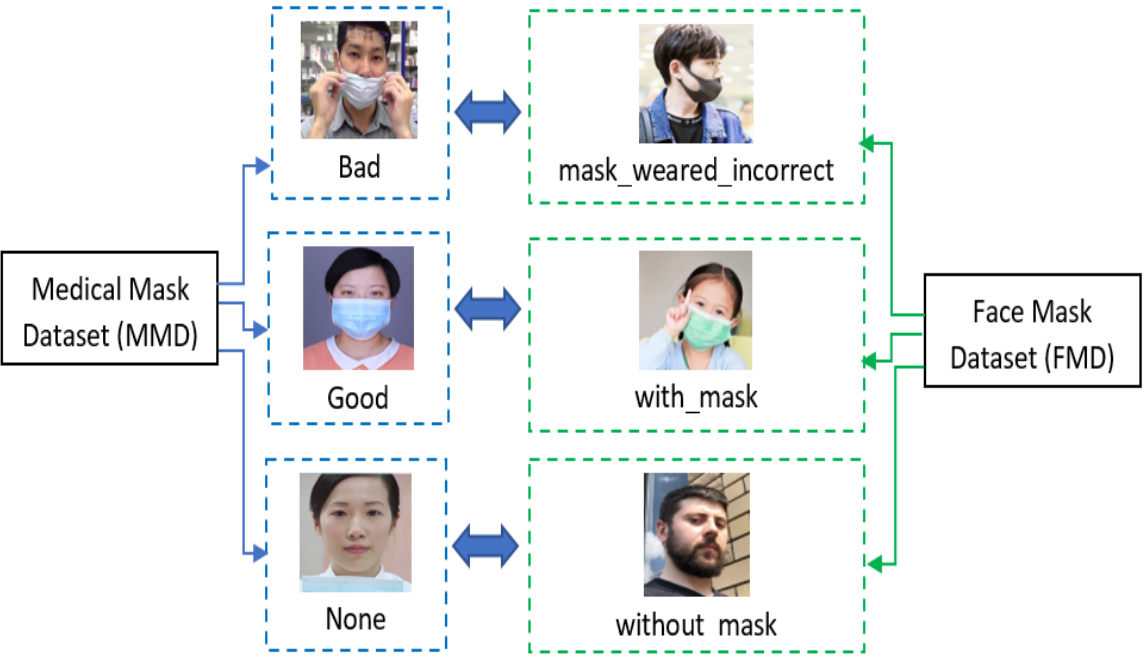
Figure 4. The combination of MMD and FMD datasets. Source of the human faces: The FMD and MMD datasets.